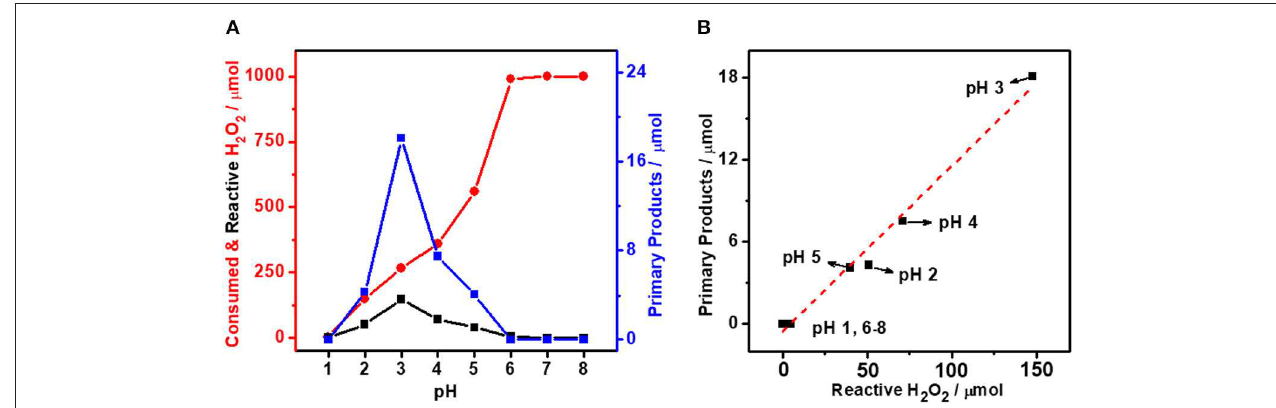
FIGURE 1 | (A) Methane oxidation reaction performance carried out with AuPd 0.1 colloid with various pH. (B) Primary products as a function of reactive H 2 O 2 with various pH. Reaction conditions: 3.0 MPa methane, 0.5 MPa O 2 , 1,000 µ mol H 2 O 2 , 50 ◦ C, 0.5h, 6.6 µ mol metal per reaction.